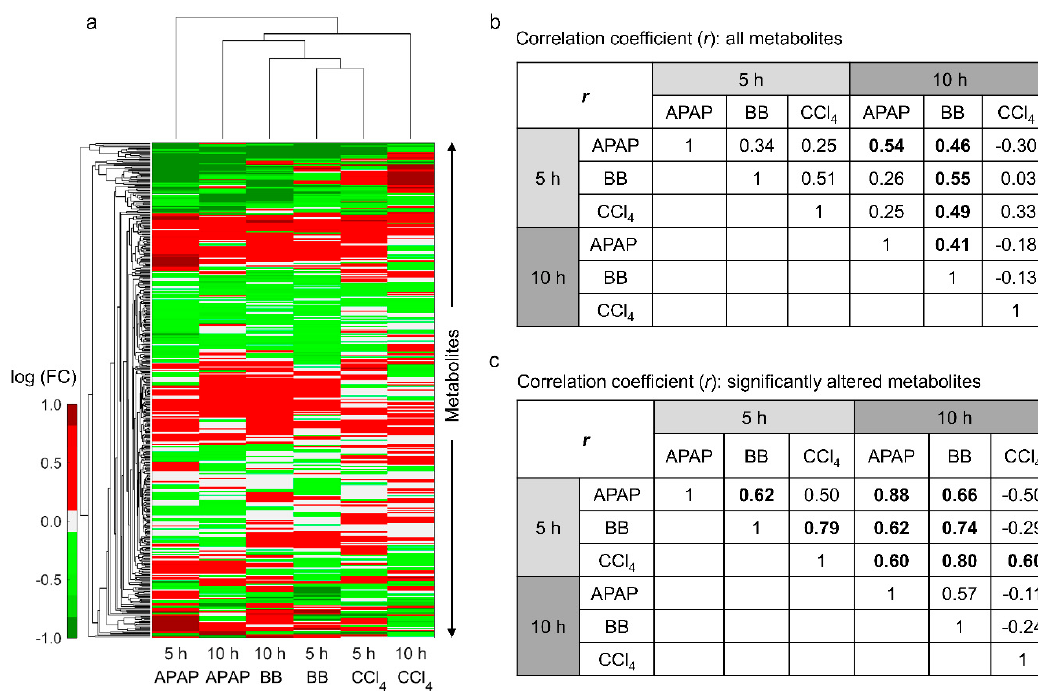
Figure 5. Identification of similarities in plasma metabolite levels from rats exposed to either APAP, BB, or CCl 4 . ( a ) Hierarchical clustering analysis of all common metabolites in plasma at 5 and 10 h after exposure of the toxicant. Pairwise correlation between the natural logarithmic fold changes (log(FC)) in metabolites observed across all three toxicants ( b ) without using any significance cut-off values and ( c ) with using only significantly altered metabolite levels (FDR < 0.1). Pairwise combinations with high correlation coefficient values are indicated in bold.